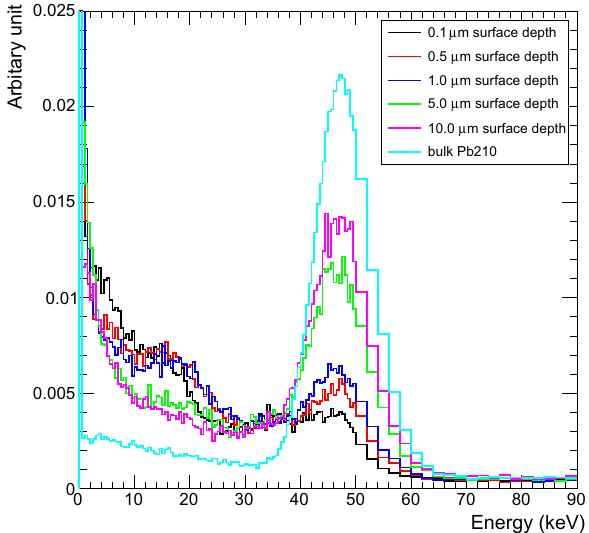
Fig. 5 Comparisonofbackground spectrasimulatedatvarious surface